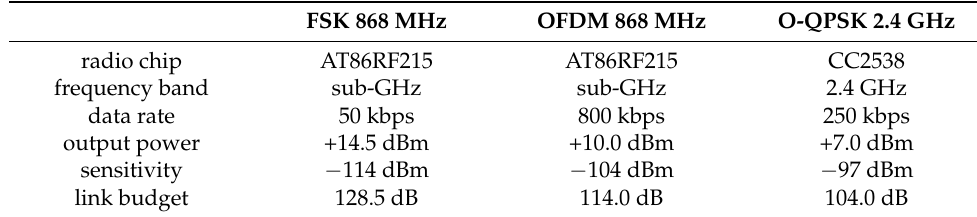
Table 1. The PHYs used by 6DYN.